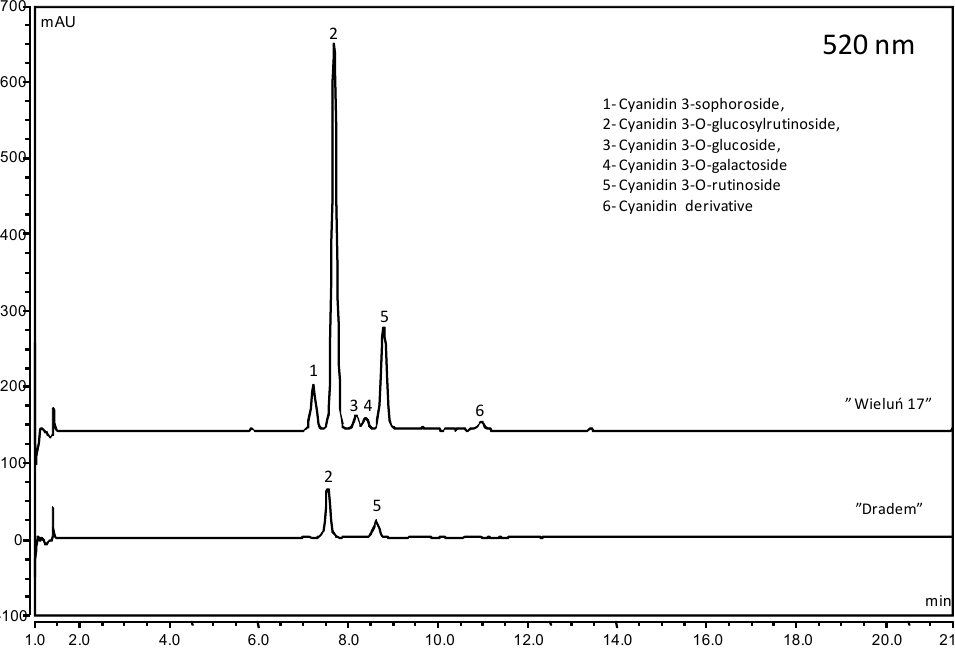
Figure 1. Chromatograms (520 nm) of sour cherry fruit cultivars with the highest and the lowest content of anthocyanins.